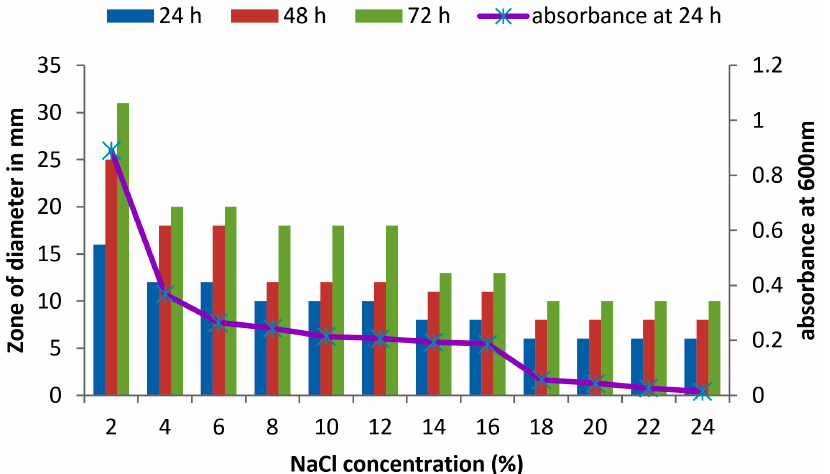
Fig. 5. Effect of NaCl on growth and DNase production of KVCMST-6A23. The zone of clearance in DNase test agar at various time of incubation indicated by bars: 24 hours, 48 hours, 72 hours and its growth indicated by its absorbance at 24 hours.